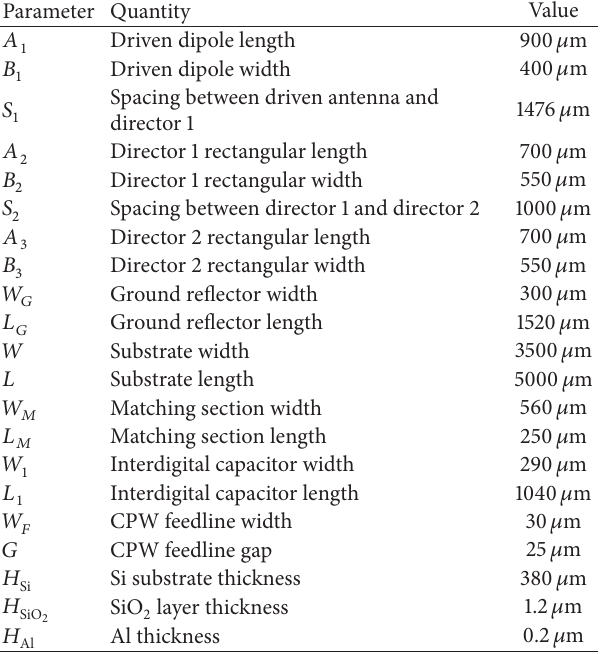
Table 2: Optimized Quasi-Yagi dipole antenna prototype II dimen-